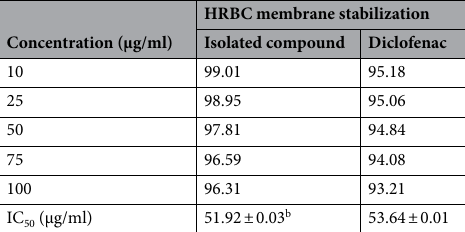
Table 2. The anti-inflammatory activity of the isolated compound. Reported values are the mean ± SD (n = 3). Means in the same raw followed by different lower case letters are significantly different (p < 0.05).